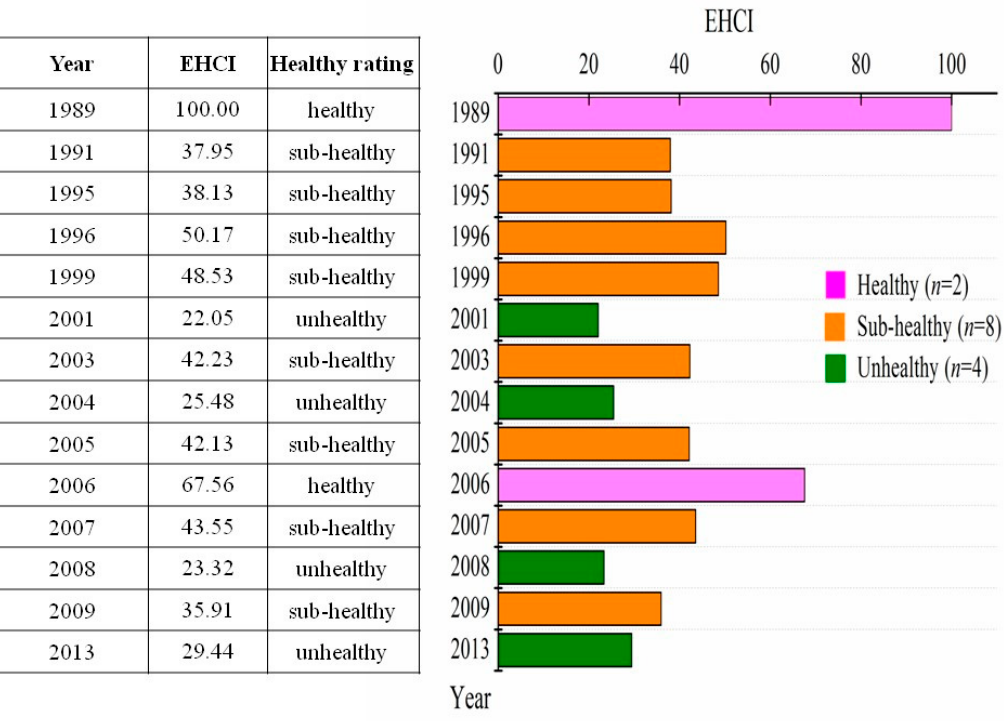
Figure 4. Ecological Health Comprehensive Index (EHCI) for the Poyang Lake wetland during 1989–2013.